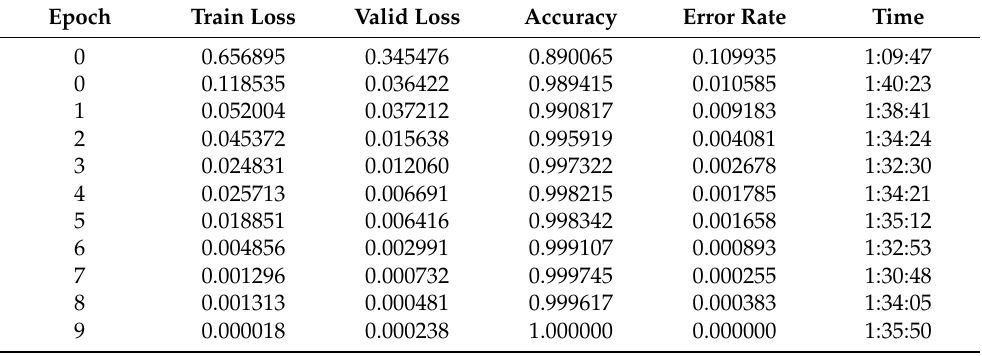
Table 3. Results of the ResNet